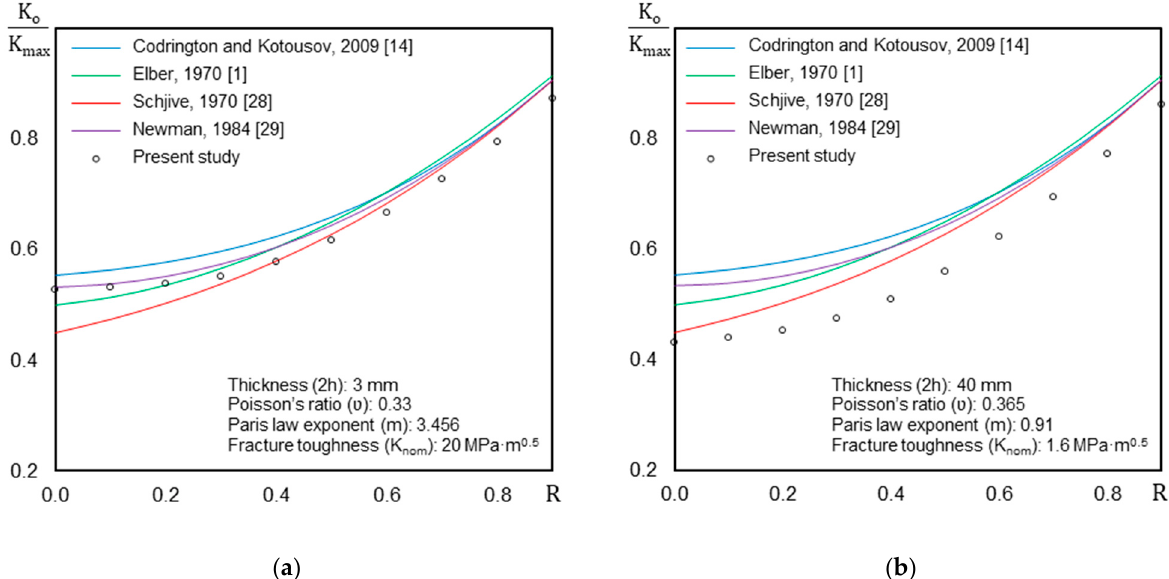
Figure 8. The ratio of the opening stress intensity factor to the maximum stress intensity factor as a function of the R ratio along the crack front: ( a ) 6082-T6 aluminium alloy; ( b ) polymethyl methacrylate.